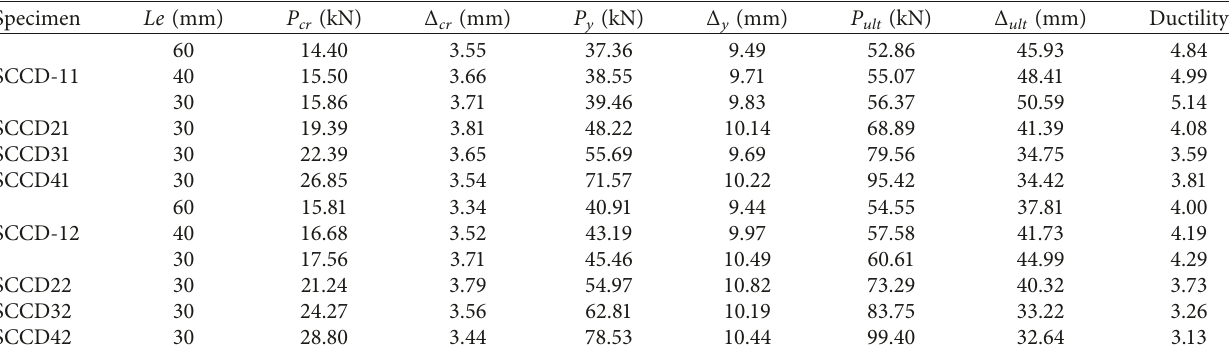
Table 6: Summary of FE simulation